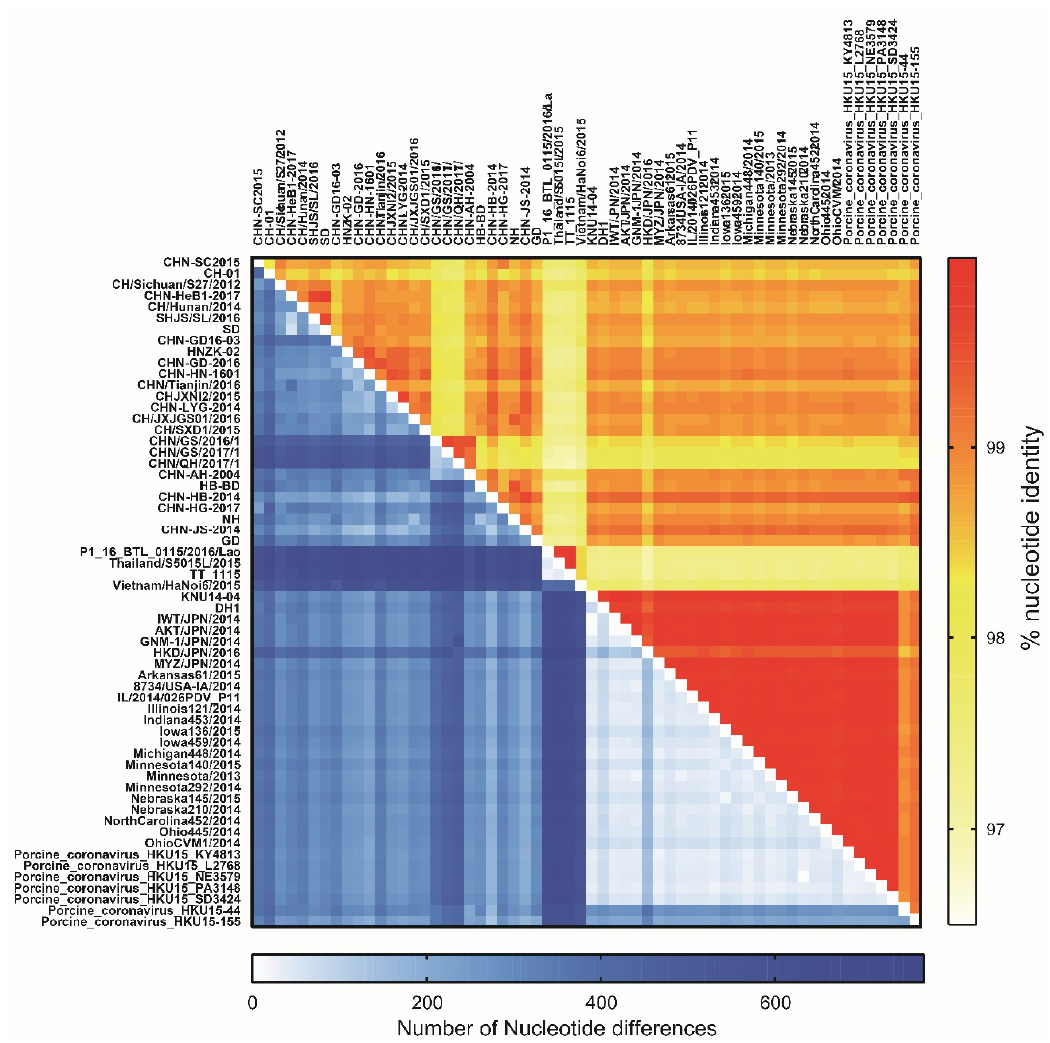
Figure 4. Heat map of nucleotide identities and differences between CHN-SC2015 and 59 reference strains in GenBank. The level of nucleotide identity (top right) and the number of nucleotide differences (bottom left) between CHN-SC2015 and other 59 reference strains were analyzed using Clustal W software in MEGA X. The nucleotide identity and difference are represented by a gradation of color; the deeper the color, the greater the identity or difference.